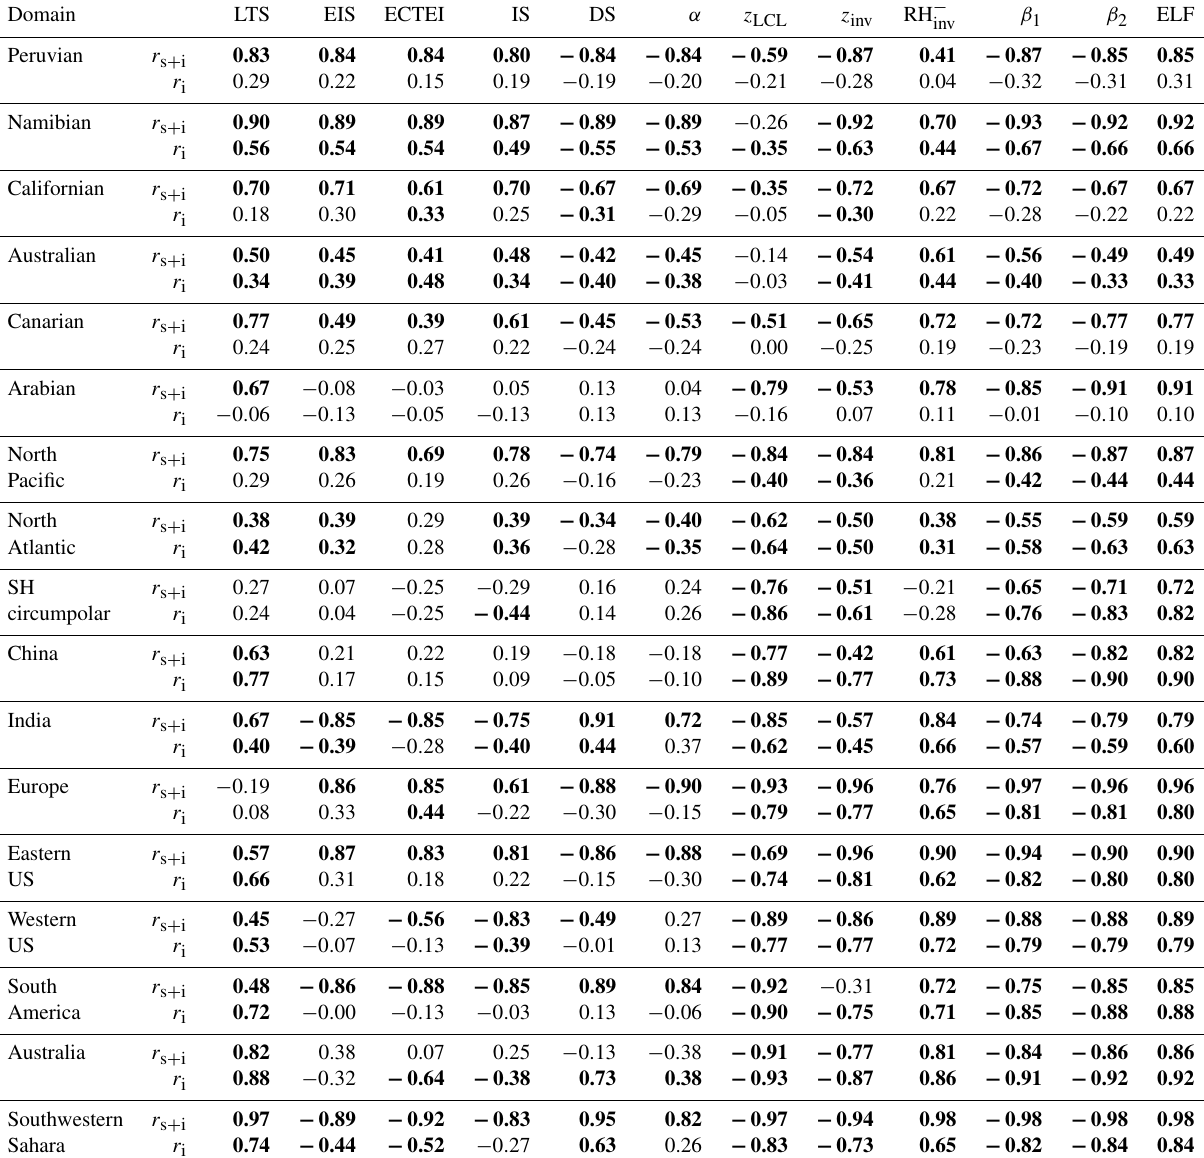
Table 2. Temporal ( r s + i : seasonal plus interannual, r i : interannual only) correlation coefficients of the seasonal LCA fitted to the individual proxy for selected regions shown in Fig. 7. Only the data satisfying 0 < α < 1 are used for this